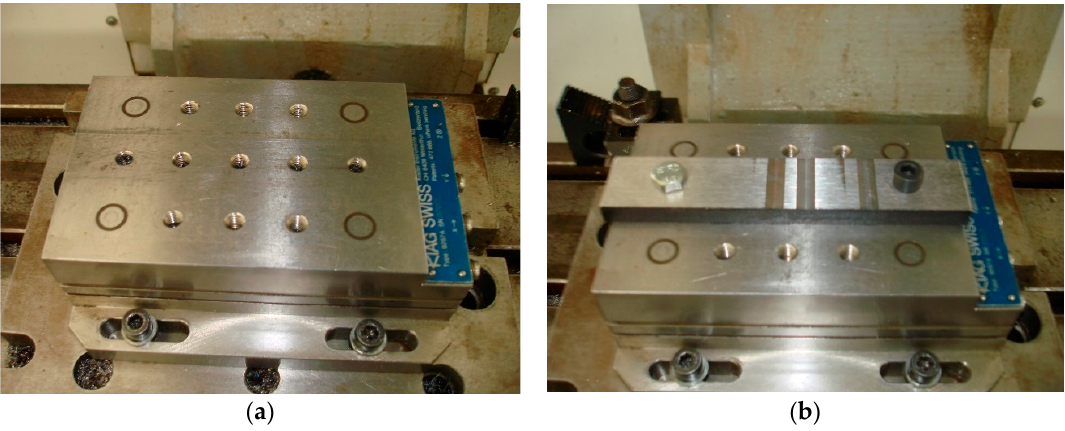
Figure 2. ( a ) Dynamometer Kirstler Type 9257A and ( b ) workpiece on the machine tool.